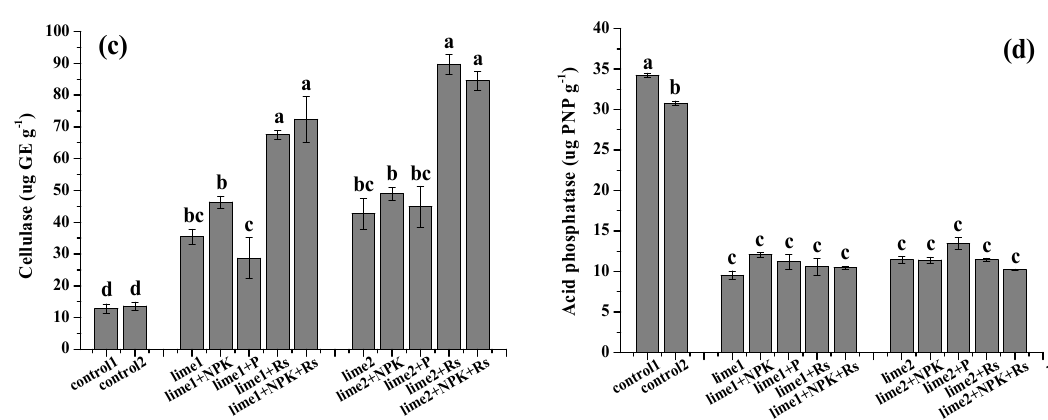
Figure 2. Soil enzyme activities in the mine soil with different amendments (means ± S.E, n = 4). The bars with different letters indicated significant differences at p < 0.05 according to LSD test. lime1 (25 t ha − 1 ), lime2 (50 t ha − 1 ), Rs (river sediment 30%, w:w); ( a ): dehydrogenase activity; ( b ):